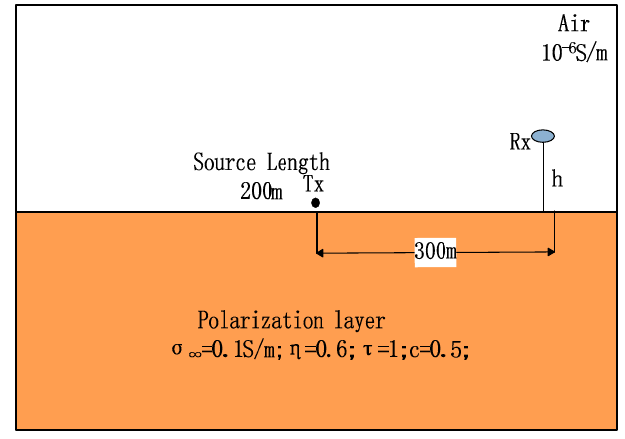
Figure 2. The half-space model with induced polarization (IP) effect.